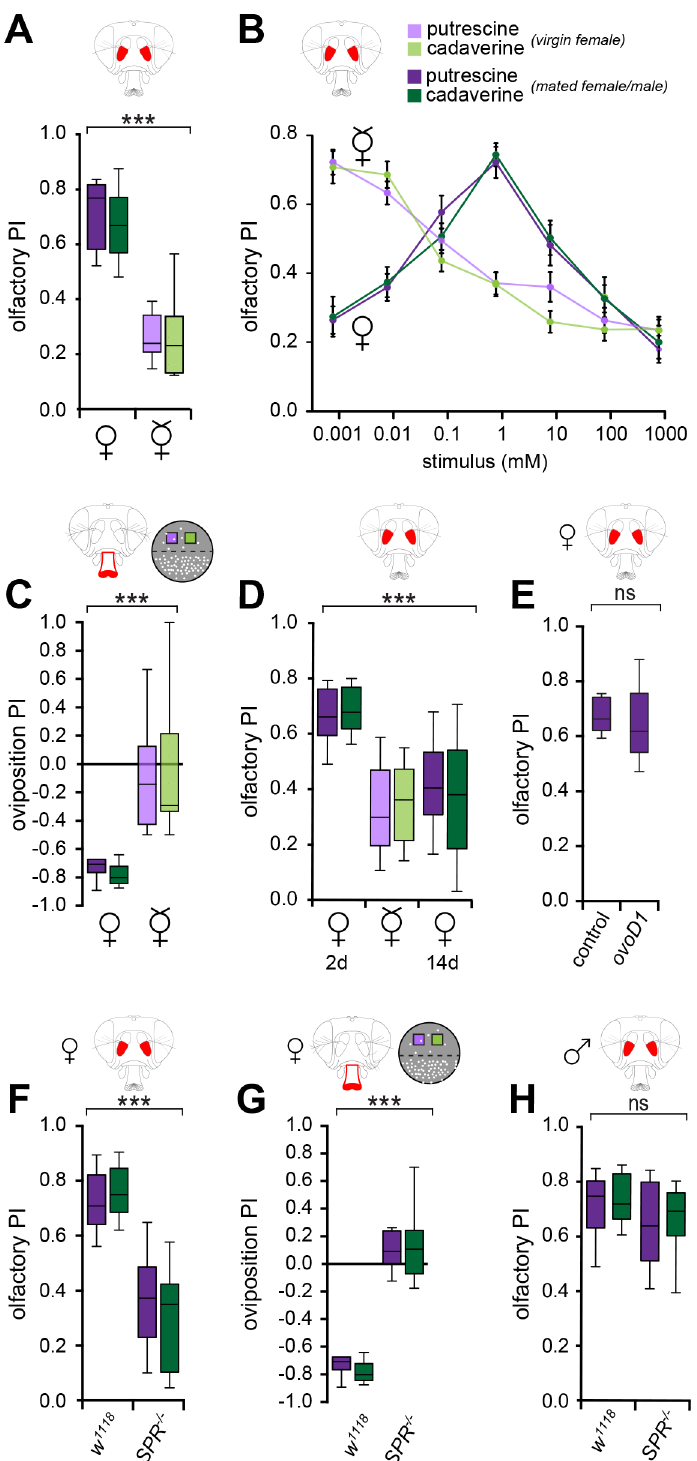
Fig 1. Mating state modulates the perception of polyamines. (A) Virgin flies are less attracted to a high polyamine concentration of 1 mM (10 ppm) as compared to mated flies. Olfactory preference index of Canton S mated ( ♀ ) and Canton S virgin ( ☿ ) females in the T-maze assay. Violet and green bars represent putrescine and cadaverine, respectively. ( n = 8, 60 mated ( ♀ ) or virgin ( ☿ ) flies/trial). (B) Mated females, unlike virgins, preferred relatively high concentrations of polyamines, naturally present in fermenting fruit (1 mM or 10ppm). By contrast, virgin females were most attracted to very low concentrations of polyamine. Line graph